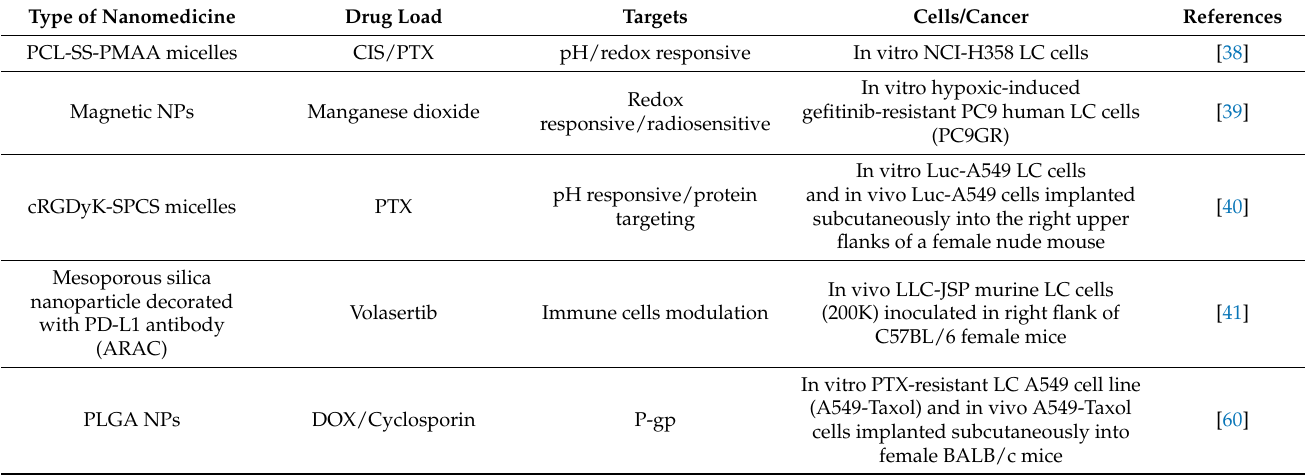
Table 1. Preclinical studies nano-based strategy to overcome DR in